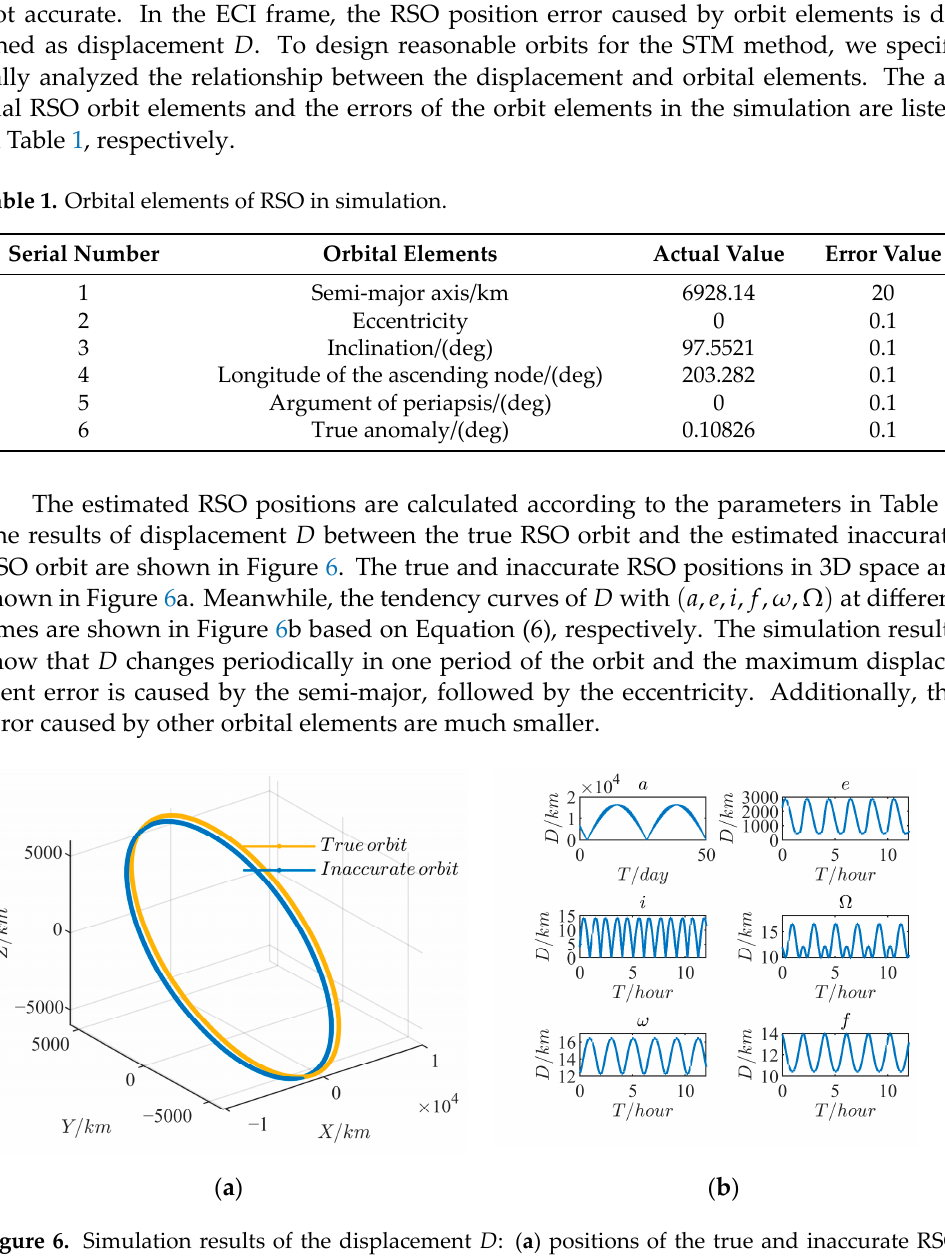
Table 2. Orbital elements of the observation satellite and the RSO. Orbital Elements